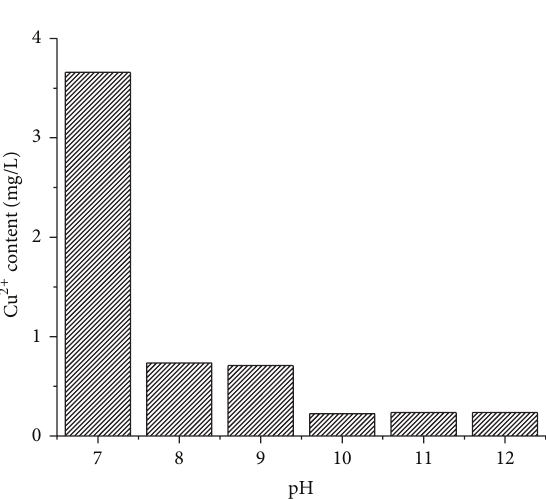
Figure 4: Effect of pH on removal of copper.